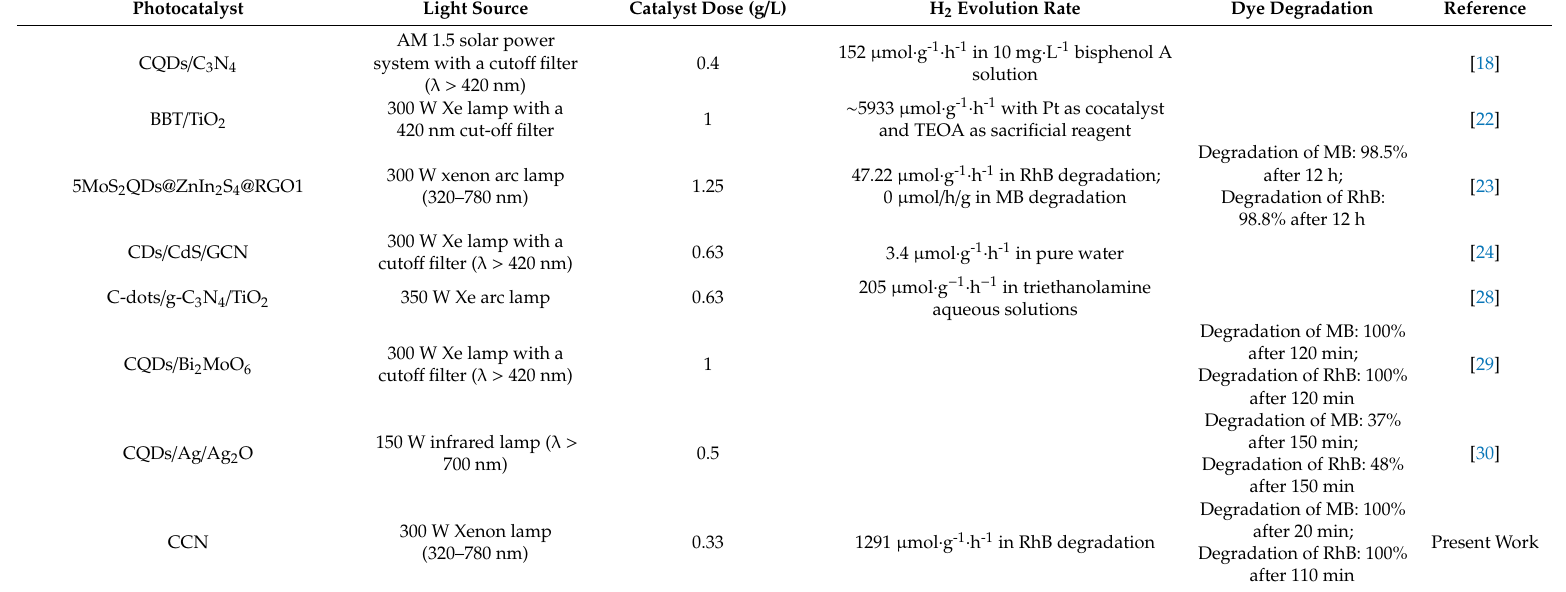
Table 1. Comparative photocatalytic results of the present work with reported catalysts for H 2 evolution rate and dye degradation